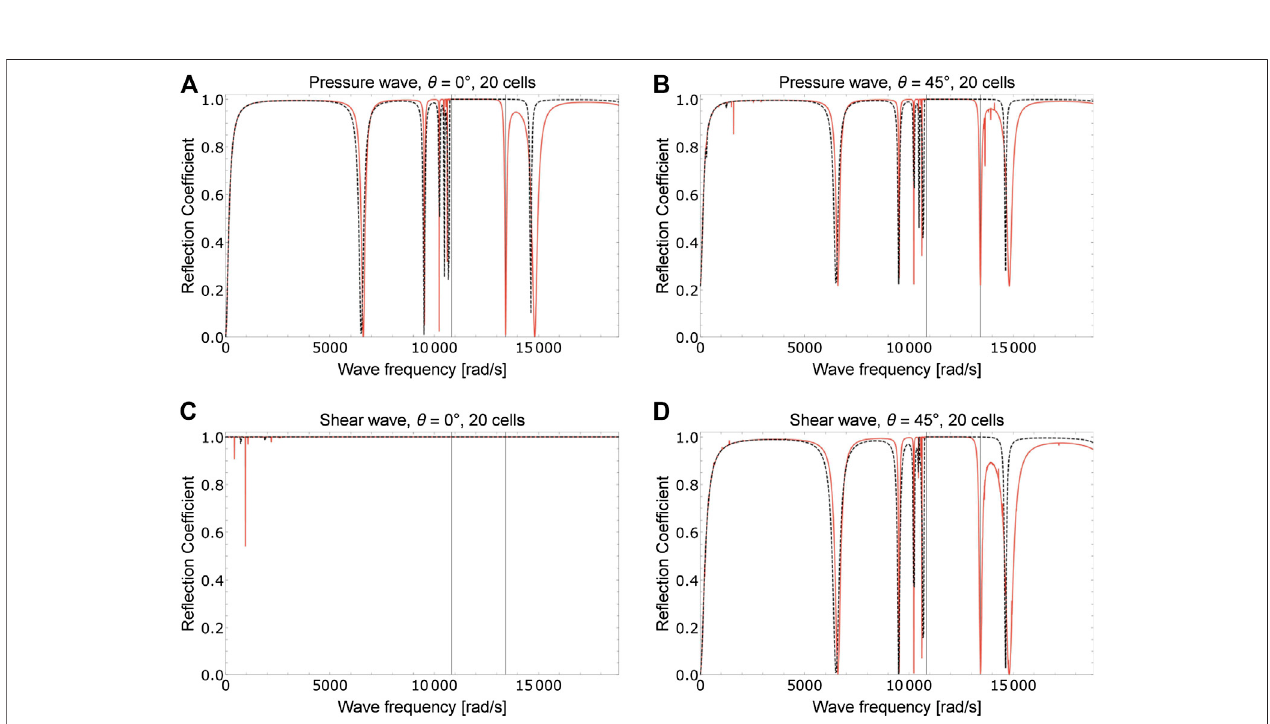
FIGURE 9 | Comparison of the microstructure ’ s (black line) and micromorphic (red line) re fl ection coef fi cient as a function of frequency for a 20 unit cells slab of MM1 and embedded in CM3 . (A) “ pressure ” normal incident wave with respect to the slab ’ s interface. (B) “ pressure ” 45 ° incident wave with respect to the slab ’ s interface. (C) “ shear ” incident wave normal to the slab ’ s interface. (D) “ shear ” 45 ° incident wave with respect to the slab ’ s interface.